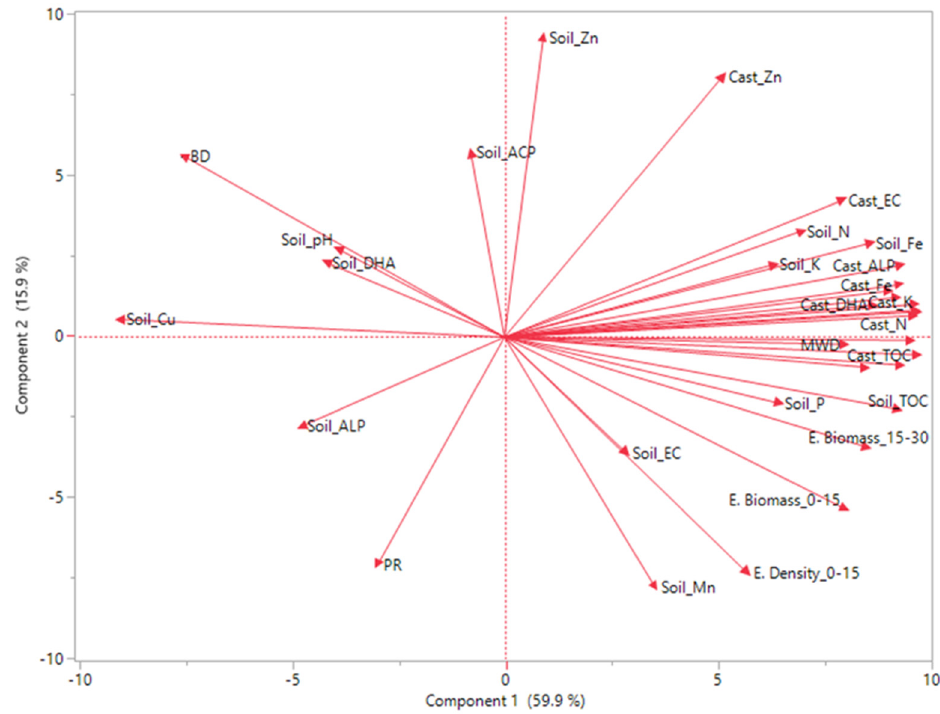
Figure 4. PCA between earthworm density (EW. D), earthworm biomass (EW. W), and physio- chemical soil parameters after 10 years of adopting CSA-based management practices. TOC—total organic carbon, N—nitrogen, P—phosphorus, K—potassium, BD—bulk density, IR—infiltration rate, MWD—mean weight diameter, DHA—dehydrogenase, ACP—acid phosphatase, ALP—alkaline phosphatase, SPR—soil Penetration resistance, EC—electrical conductivity.